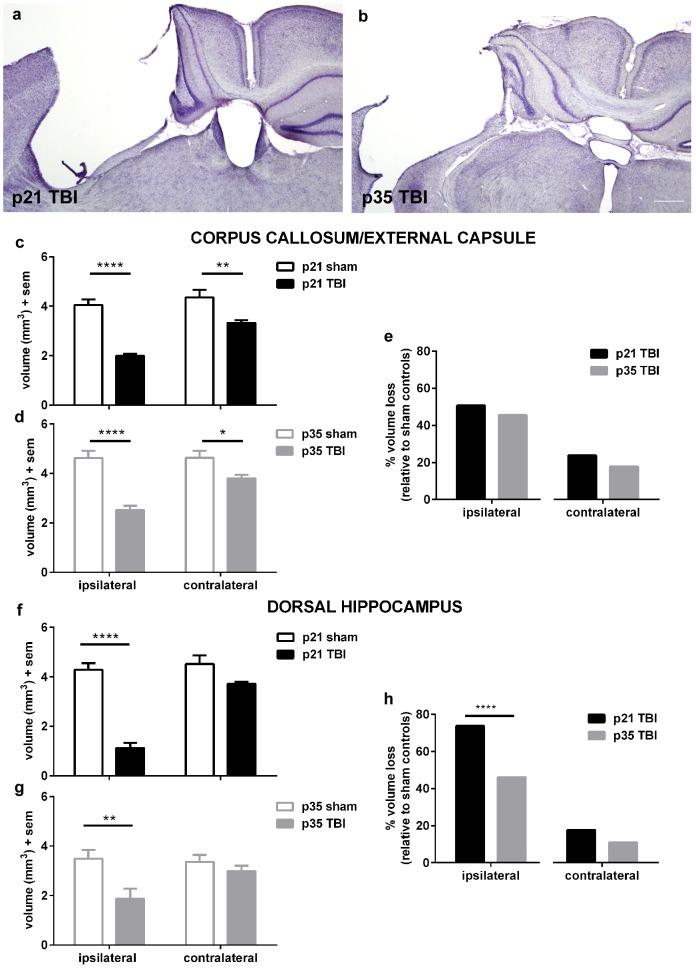
Social deficits are associated with white matter atrophy and hippocampal loss.TBI at both a pediatric (a) and adolescent age (b) resulted in a distinct pattern of unilateral cortical and hippocampal loss by adulthood (scale bar = 500 µm). Volumetric analysis of the corpus callosum revealed pronounced volumetric loss of the corpus callosum/external capsule bilaterally after injury at p21 (c; ****p<0.0001, **p<0.01). Similar loss was also evident after injury at adolescence (d; ****p<0.0001, *p<0.05). When expressed as injury-induced tissue loss relative to age-matched sham controls after injury at p21 compared to p35 (e), both cohorts showed ∼50% volume loss of the ipsilateral corpus callosum and ∼20% loss on the side contralateral to injury (n.s.). Volume of the dorsal hippocampus was also quantified, revealing considerable loss of the ipsilateral hippocampus after injury at p21 (f) and p35 (g). When expressed as tissue loss relative to age-matched sham controls (h), greater tissue ipsilateral hippocampus loss was evident after injury at p21 compared to injury at adolescence.